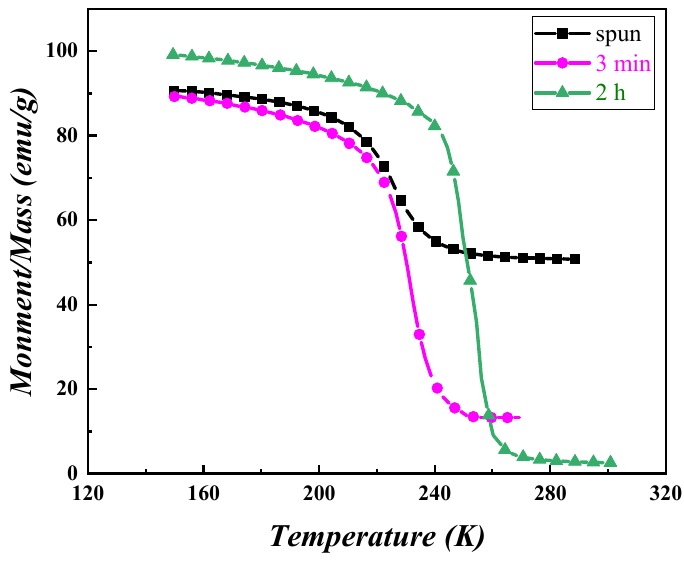
Figure 7. Thermomagnetic curves of 35 m/s LaFe 11.5 Si 1.5 C 0.2 ribbons annealed at 1273 K for different times.